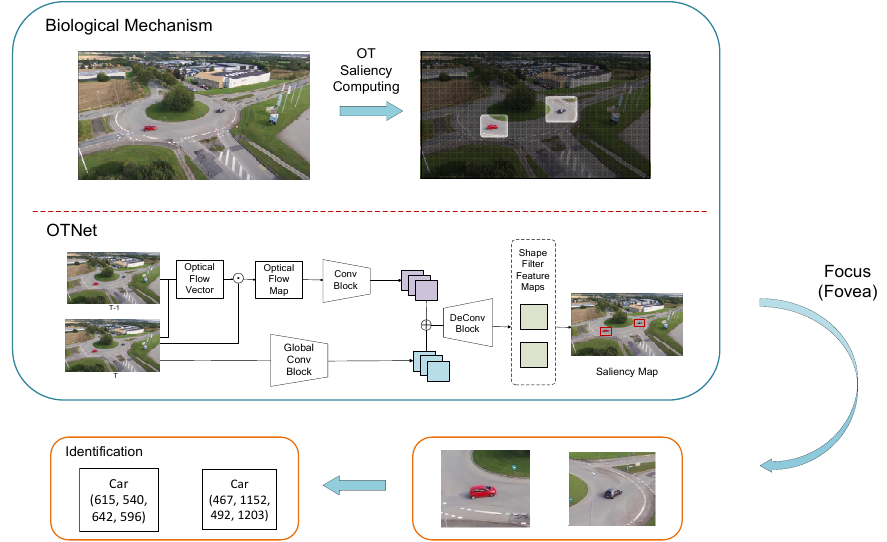
Figure 2. The structure of our algorithm.